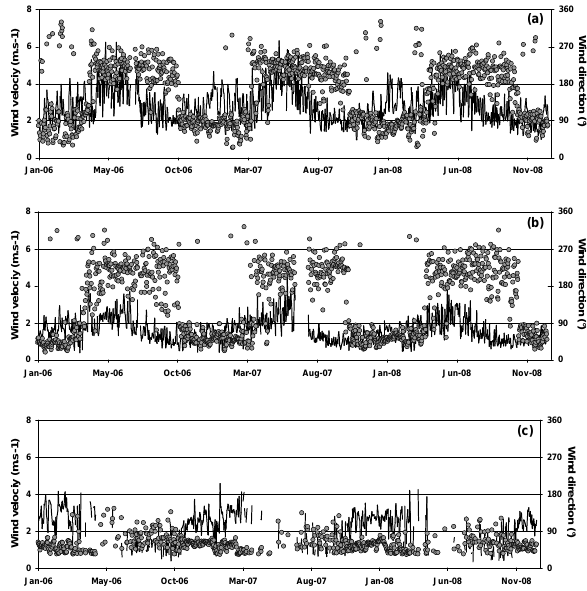
Fig. 6. Daily mean surface wind velocity (line) and daily wind direction (dots) in Banizoumbou (a) , Cinzana (b) and M’Bour (c) from January 2006 to December 2008 (note that the wind velocities are lower in Cinzana due to a lower position of the wind